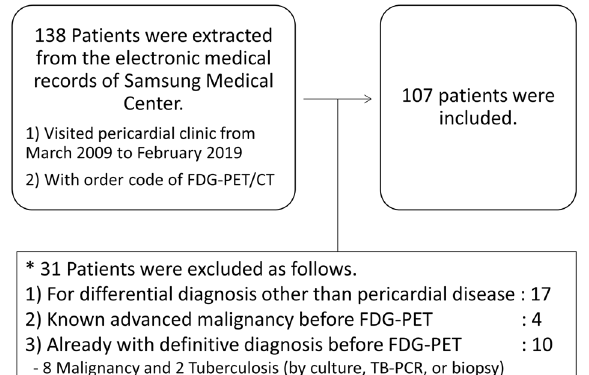
Figure 1. The study